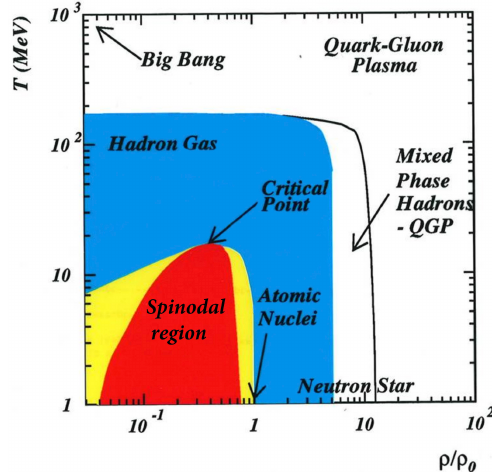
Figure A2. From Ref. [70]. Phase diagram T ( ρ ) for nuclear matter (density ρ is expressed in units of ρ 0 ≡ ρ nucleus (cid:39) 2.85 × 10 14 g/cm 3 , temperature T is expressed in MeV units, 1 MeV (cid:39) 10 10 K): the liquid–gas mixed phase region (yellow area, which ends up at the critical point) contains the spinodal region (red